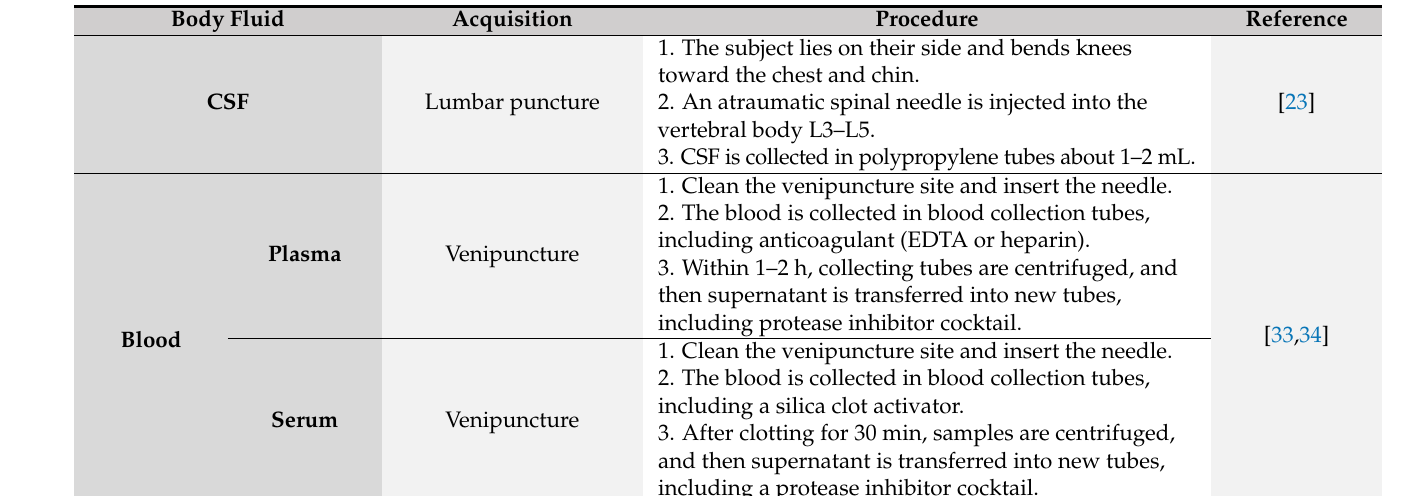
Table 4. Summary of CSF and blood acquisition procedures.